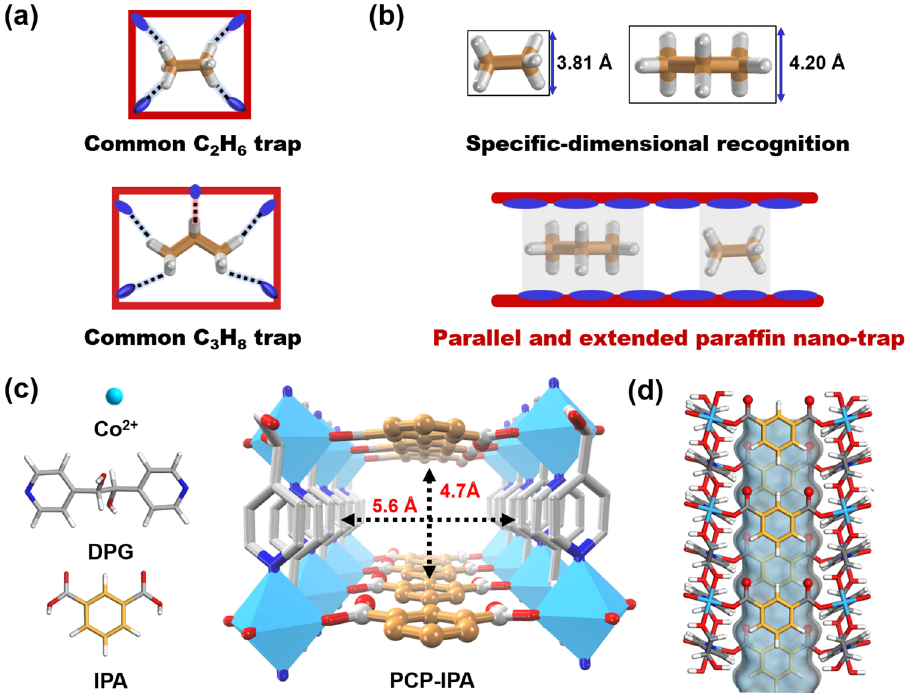
Fig.1|SchemeandstructureofPCP-IPA.a Schematicillustrationofthecommon paraf fi n-trap channel, b schematicillustrationof theparallelandextendedparaf fi n nano-trap channel, ( c ) the building blocks (Co II , DPG, and IPA organic ligand) and